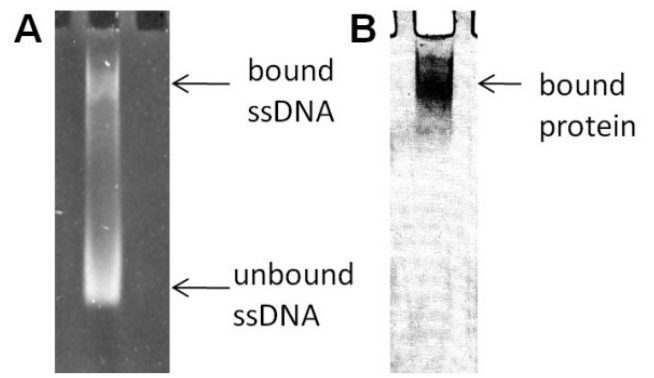
Figure 4. Electrophoretic Mobility Shift Assay. ( A ). The typical separation between bound oligonucleotides and unbound oligonucleotides. The 6% polyacrylamide gel was stained by ethidium bromide; ( B ). The gel was stained by Coomassie Brilliant Blue R-250 to confirm the complex form of the target protein and ssDNA (taken from reference